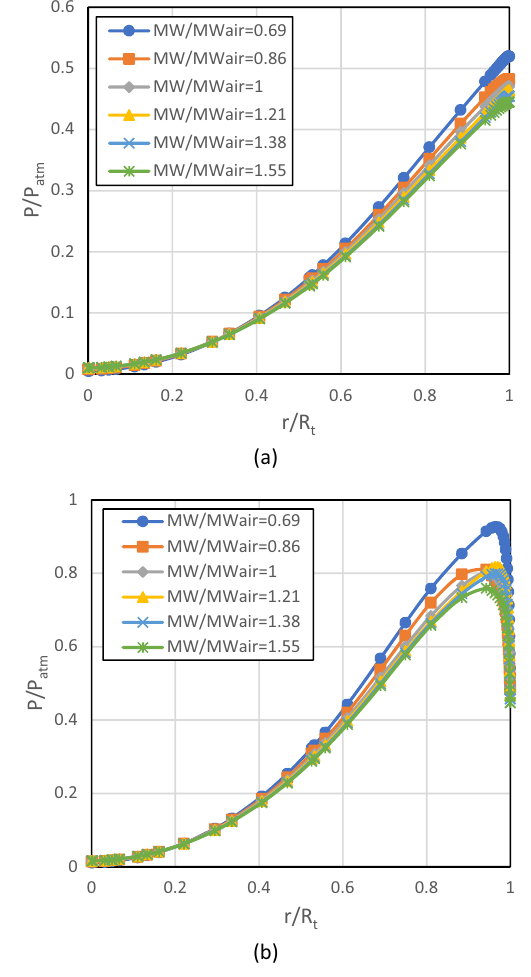
Fig. 9 Dimensionless pressure profiles versus radial direction plot- ted at z∕L = 0.63 for various molecular weight ratios. a Static and b total pressures with 400 kPa at the inlet, 0 kPa at the cold outlet and 30 kPa at the hot outlet